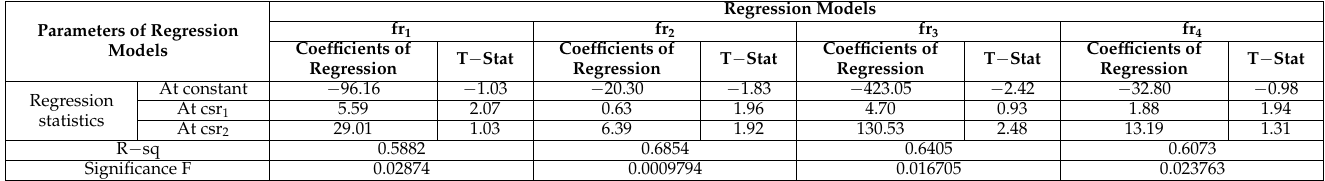
Table 5. Regression models of the contribution of CSR to financial risk management of companies in